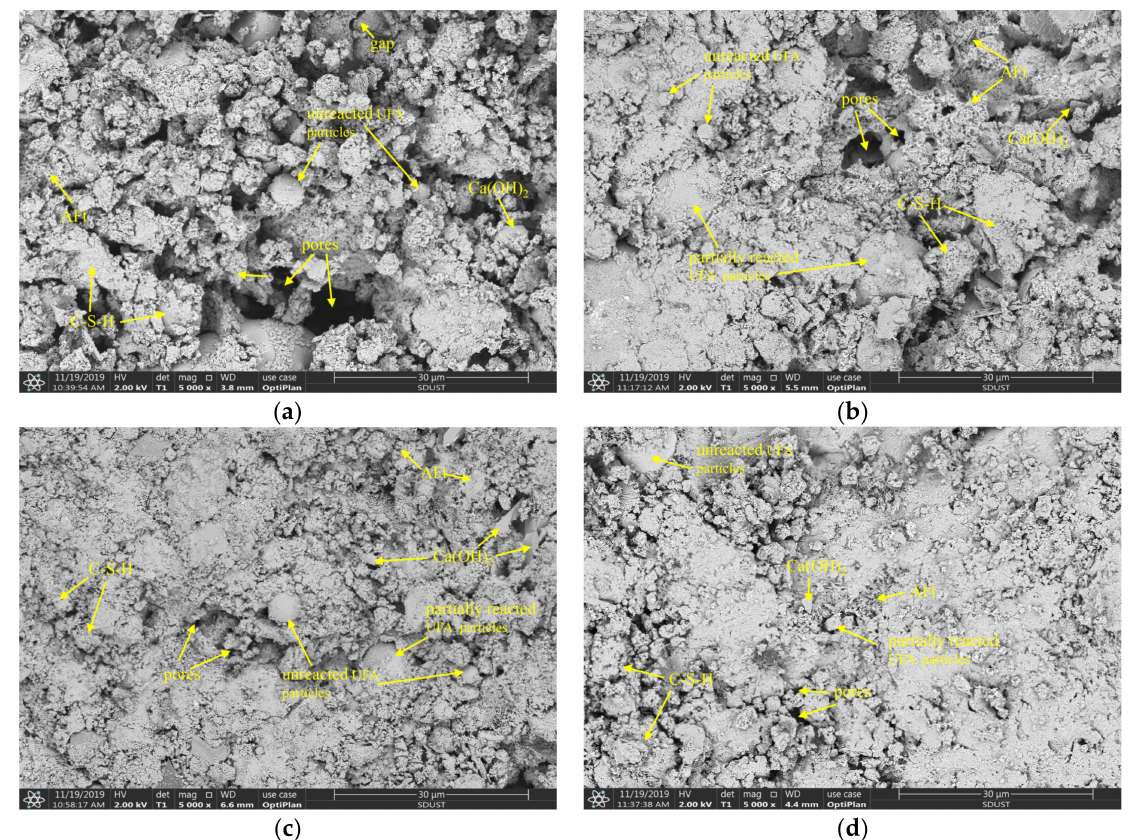
Figure 15. SEM images of 7-day hardened UC-based slurry: ( a ) G1; ( b ) G2; ( c ) G3; ( 4 )